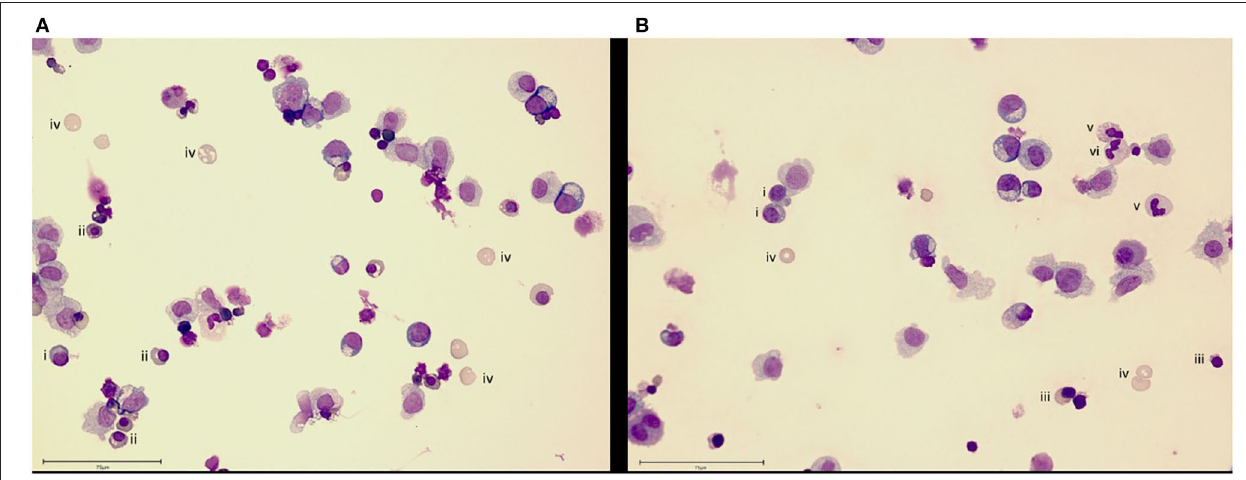
FIGURE 3 | Bone marrow cell maintenance and differentiation in an MPS. Culture of human CD34 + cells on a human mesenchymal stem cell-seeded scaffold in the recirculating HUMIMIC Chip2 for (A) 17 or (B) 24 days shows differentiation into erythroid (day 17) and then, additionally, neutrophil (day 24) lineage cells. Cells are identified as (i) basophilic normoblast, (ii) polychromatic normoblast, (iii) orthochromatic normoblast, (iv) reticulocyte, (v) band cell and (vi) neutrophil. Scale bar − 75 µ m.